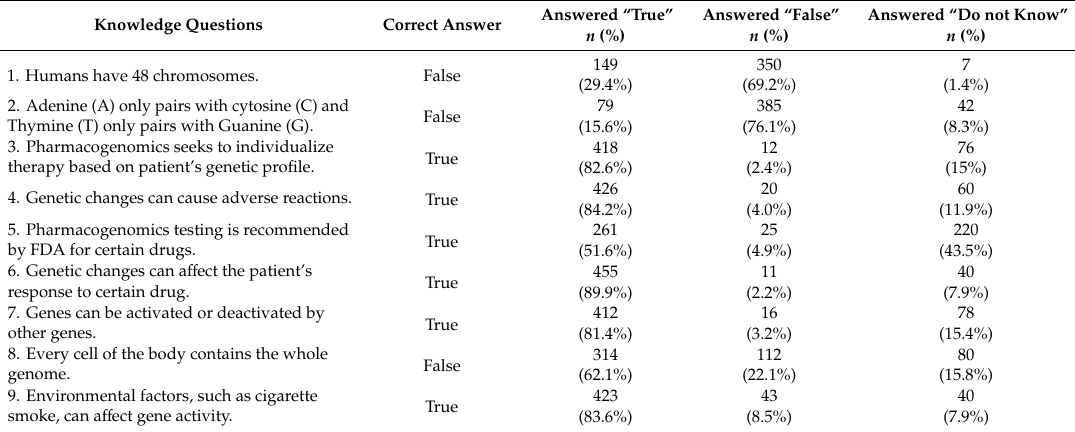
Table 2. Questions assessing genomic medicine and pharmacogenomics’ knowledge among students ( n =